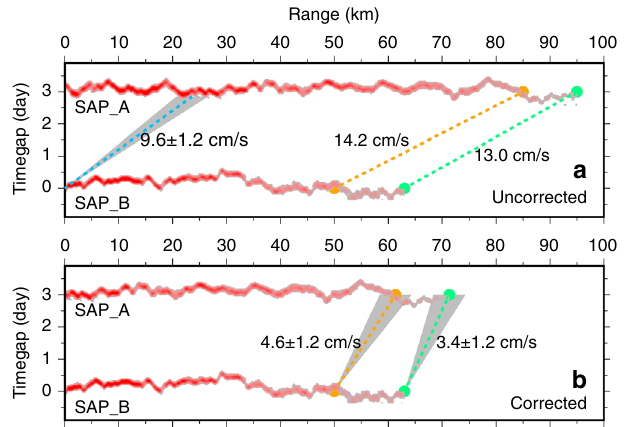
Fig. 5 Lengthening rate estimation by removing the mean background current. a Observed spatio-temporal locations of the re fl ections (red) mapped on seismic pro fi les SAP_A and SAP_B. The blue dashed line represents the displacement and its uncertainty (grey) caused by the background current speed of 9.6 ± 1.2 cm/s. The yellow and green dots show the tip locations from AVO and stacked sections, respectively. The yellow and green dashed lines show their absolute movements with speeds of 14.2 cm/s and 13.0 cm/s, respectively. b Same as ( a ) but after the removal of the movement caused by the background current to show the estimated lengthening speeds from SAP_B to SAP_A as determined from the pre-stack data of 4.6 ± 1.2 cm/s (orange) and stacked data of 3.4 ± 1.2 cm/s (green)